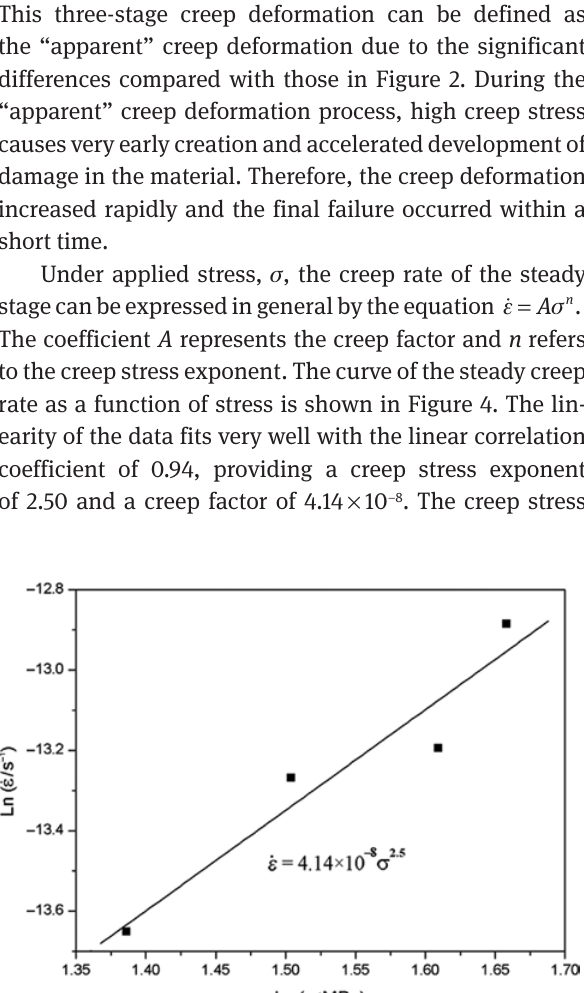
Table 1: Average strain difference in the steady creep stage. Stress range (MPa)